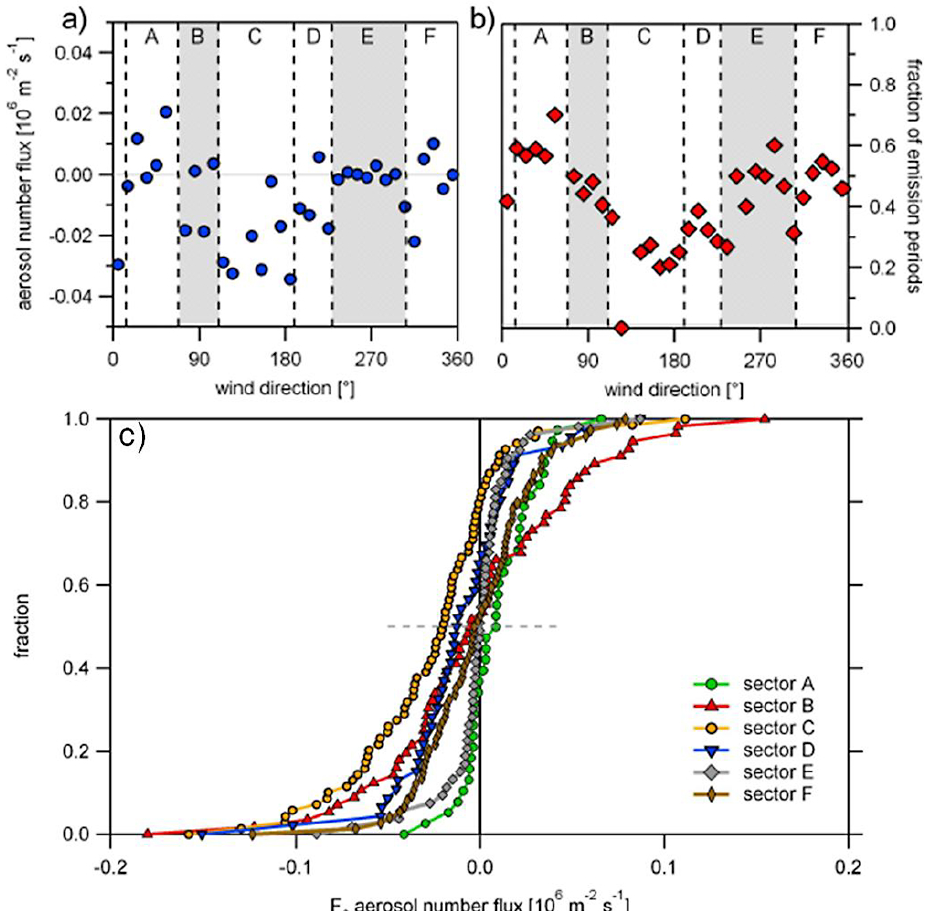
Fig. 15. Bin-averaged, with six different sectors (A–F) indicated, (a) median aerosol number fluxes over 10 ◦ wind direction bins and (b) time fraction of emission episodes averaged overlapping 30 ◦ wind bins plotted every 10 ◦ , with (c) the cumulative distribution of aerosol number fluxes for the six different sectors. The sectors are determined according to upwind surface characteristics, where A and F are shorter and longer open water fetch, C and D are rougher and smoother ice surfaces and B and E (grey shaded) are a mixture of open water and ice. Figure is from Held et al.